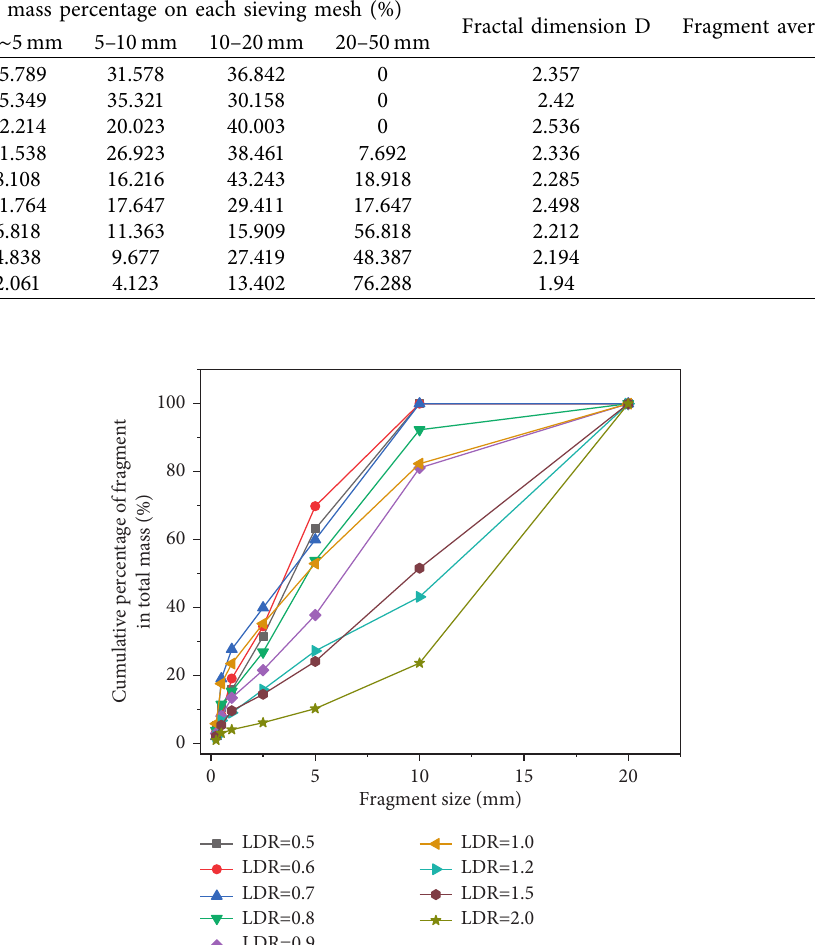
Figure 5: Fragment distribution of different length-to-diameter ratios and cumulative mass percentage on the sieving